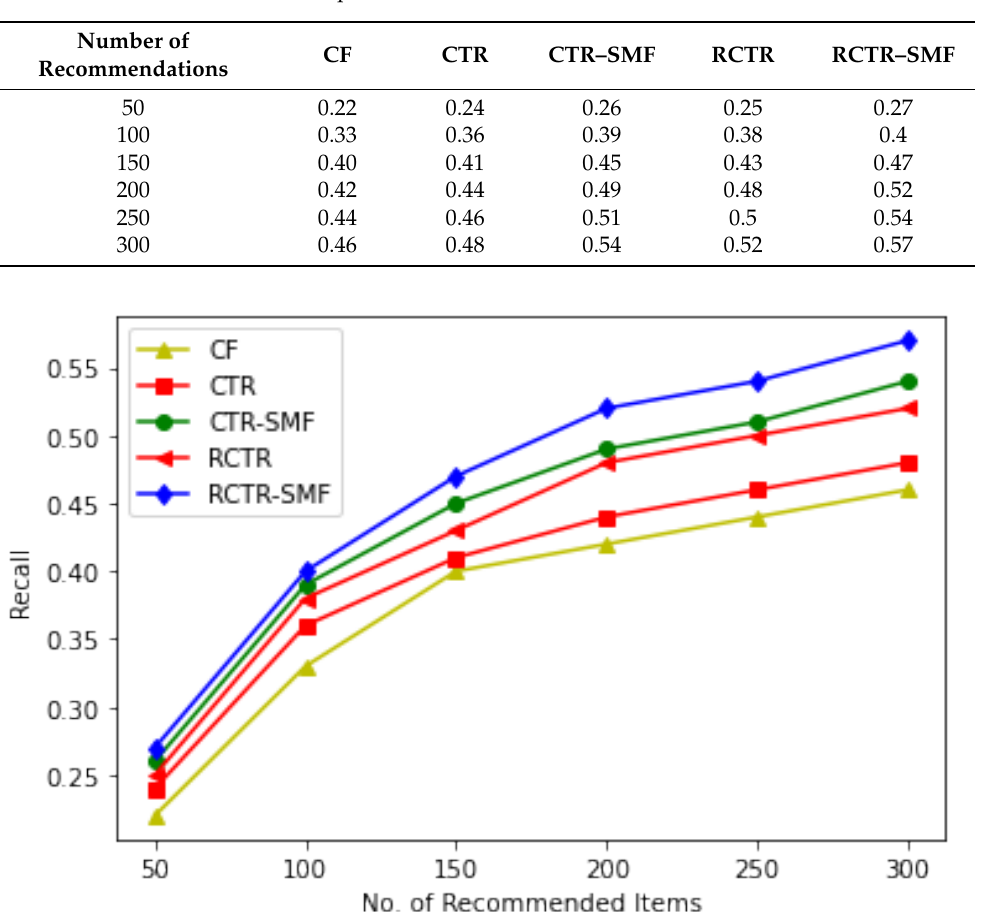
Table 3. Overall Performance Comparison.